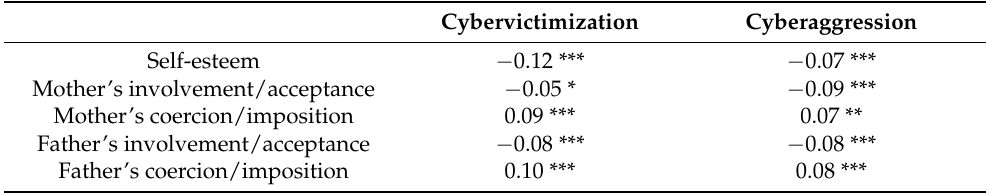
Table 2. Partial correlations of cybervictimization and cyberaggression with self-esteem and with parents’